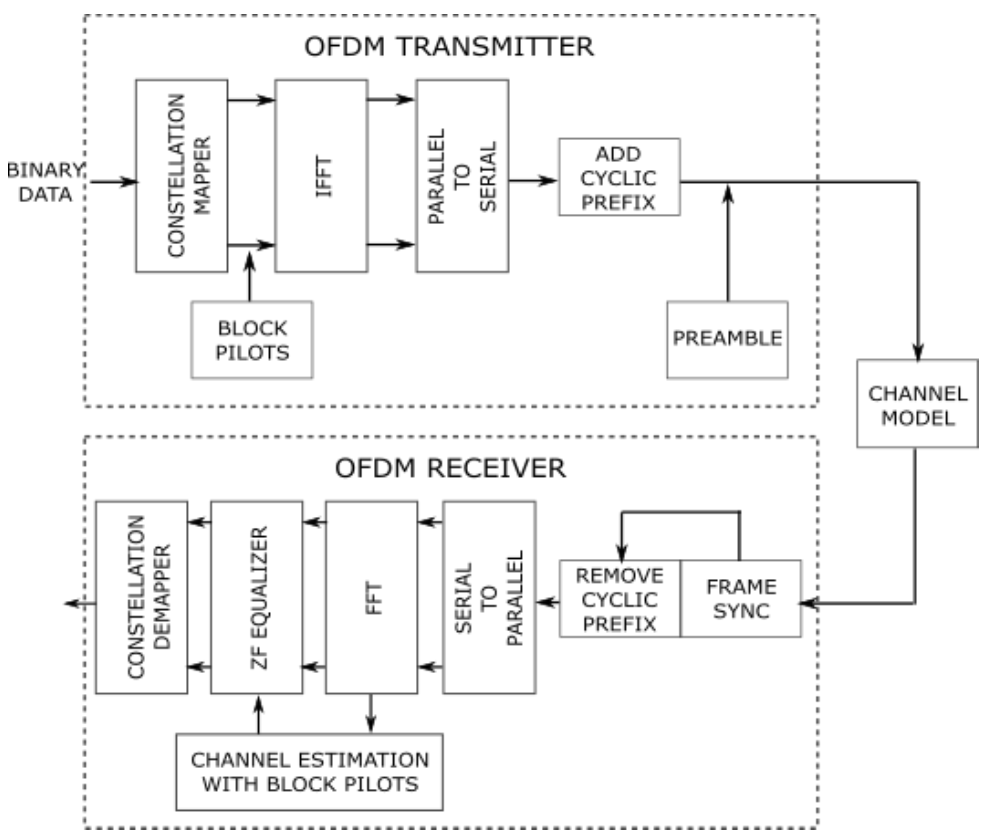
Figure 3. System model of the OFDM baseband